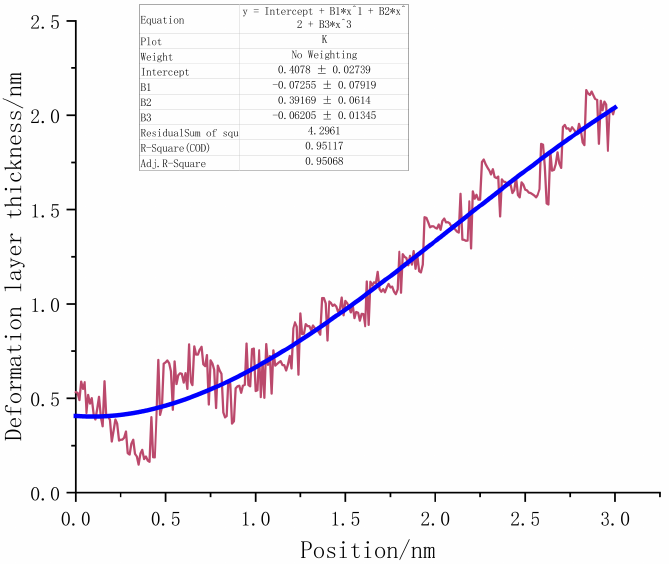
Figure 27. The relationship between the deformation layer and the loading depth when the (111) surface was